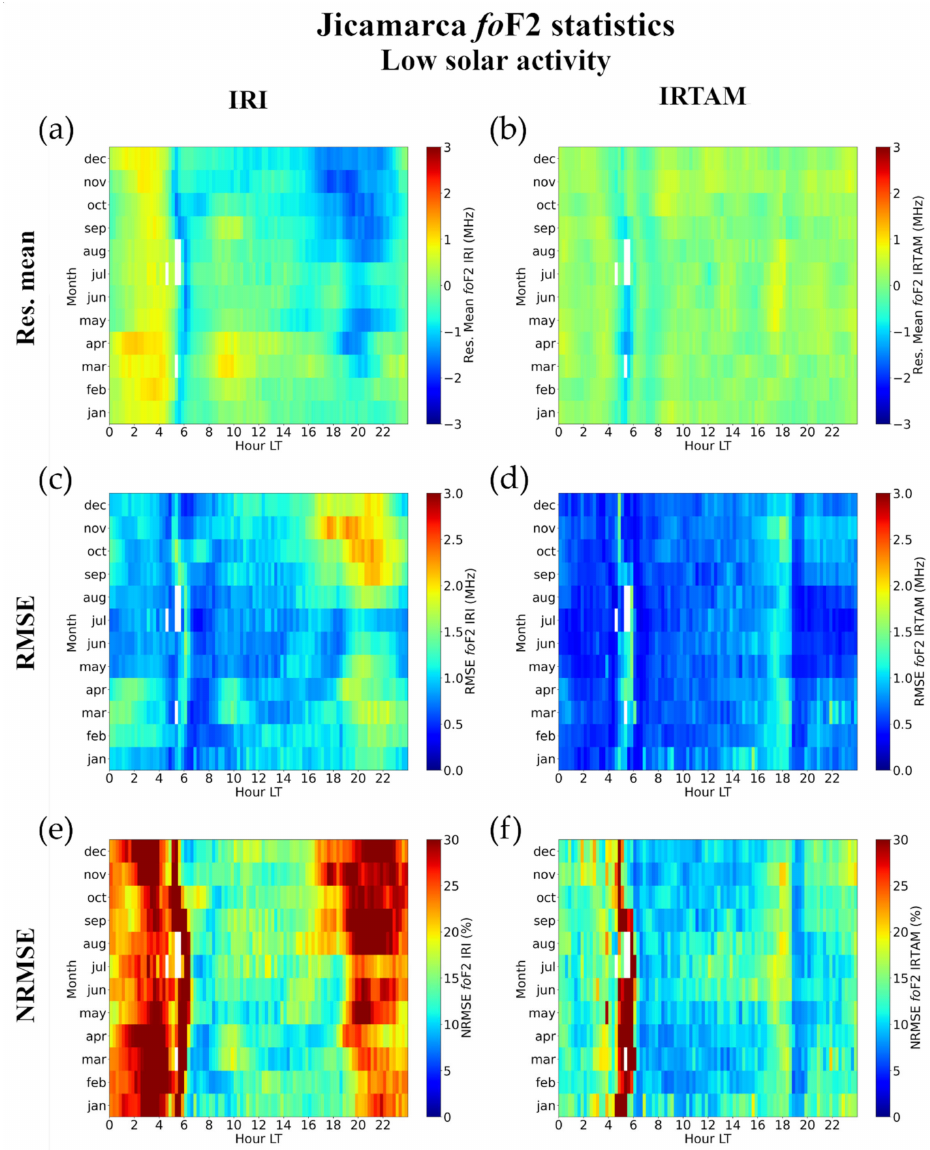
Figure 4. Grids of ( a , b ) Res. Mean , ( c , d ) RMSE , and ( e , f ) NRMSE values calculated between fo F2 values modeled by ( a , c , e ) IRI and ( b , d , f ) IRTAM, and those measured by the Jicamarca ionosonde for LSA. Monthly values ( y -axis) are binned in fifteen-minute-wide bins in LT ( x -axis). The white color highlights bins with less than ten counts for which values were not calculated because they were considered not statistically